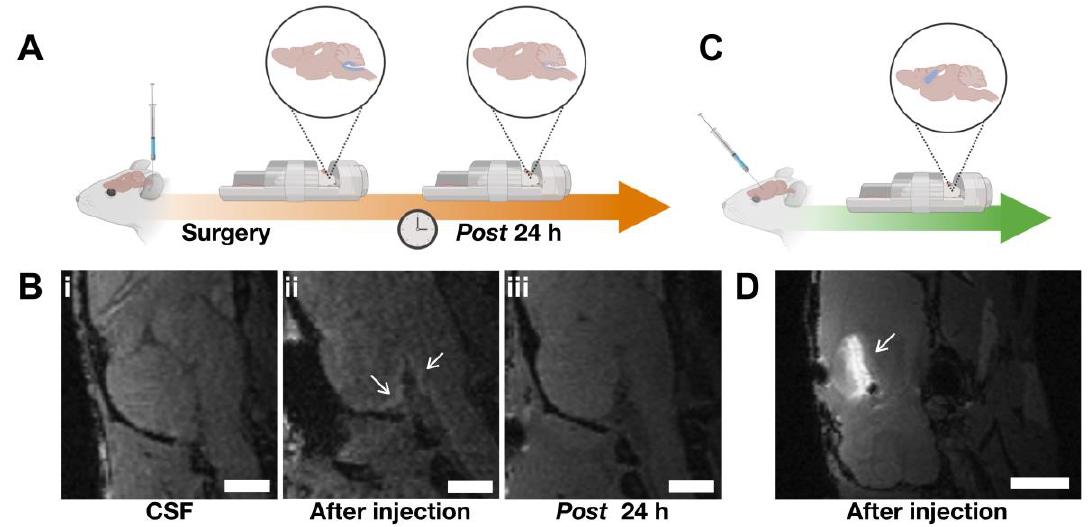
Figure 4. Magnetic resonance T1 weighted imaging of Mn-based GG-MA hydrogels. ( A ) Schematic representation of the in vivo assessment of Magnetic Resonance Imaging (MRI) signal; ( B ) T1 weighted image of ( i ) control MBP shi/shi /rag2 mouse; ( ii ) hyperintense signal (arrows) on MR image represent Mn-based GG-MA hydrogel directly after intrathecal transplantation in MBP shi/shi /rag2 mice (approximately 20 min after injection); ( iii ) MR scan 24 h after transplantation, where hydrogels are not visible in intrathecal space; ( C ) schematic drawing of intraparenchymal injection and MR scanning; ( D ) MR scan after transplantation of Mn-based GG-MA hydrogel in the parenchyma of MBP shi/shi /rag2 mice with prominent hyperintensity (arrow) showing biodistribution of Mn-based GG-MA hydrogel. Scale bar: 2 mm. Schematic representations created with BioRender.com.